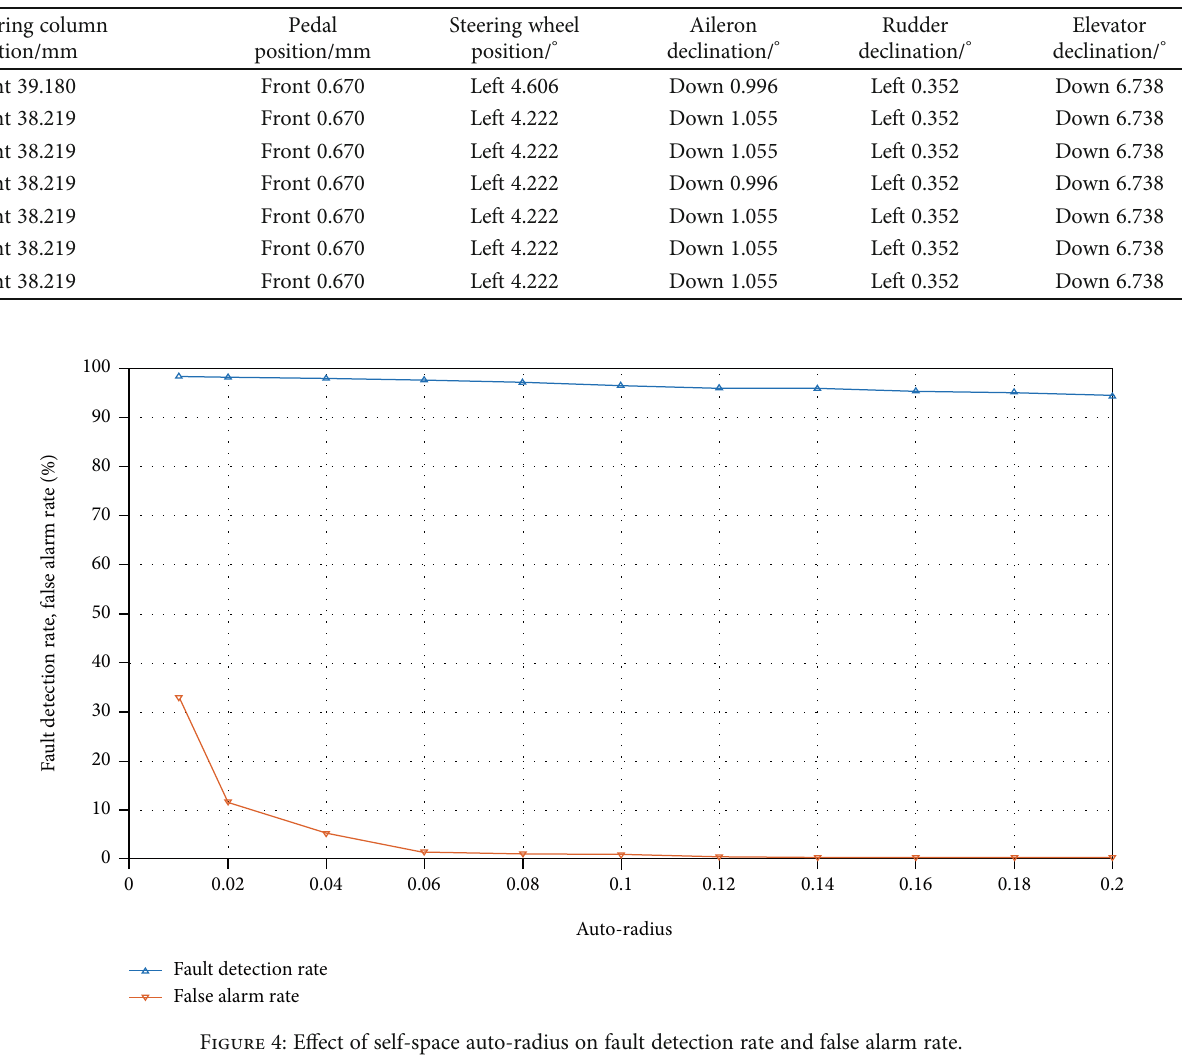
Figure 3: The main structure of the aircraft control system. Table 1: Aircraft fl ight parameter data (partial).